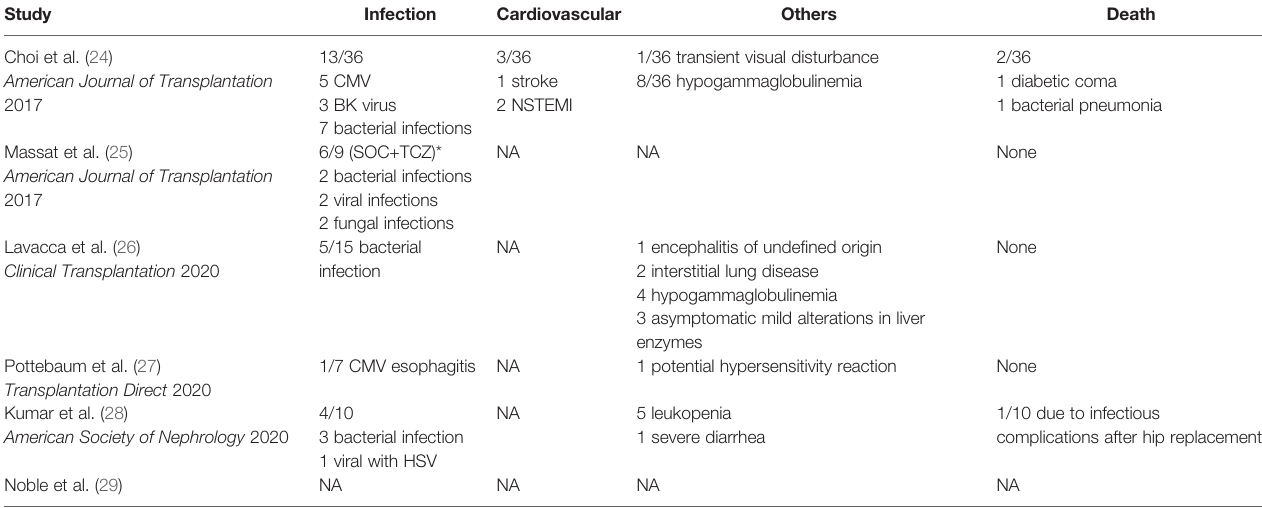
TABLE 3 | Adverse